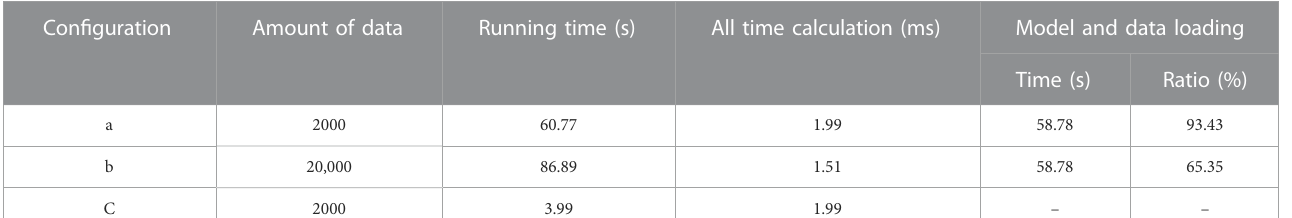
TABLE 5 Program running time statistics.